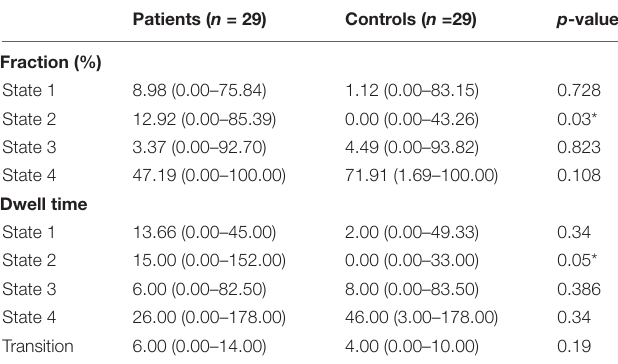
TABLE 2 | The results of Mann–Whitney U test.